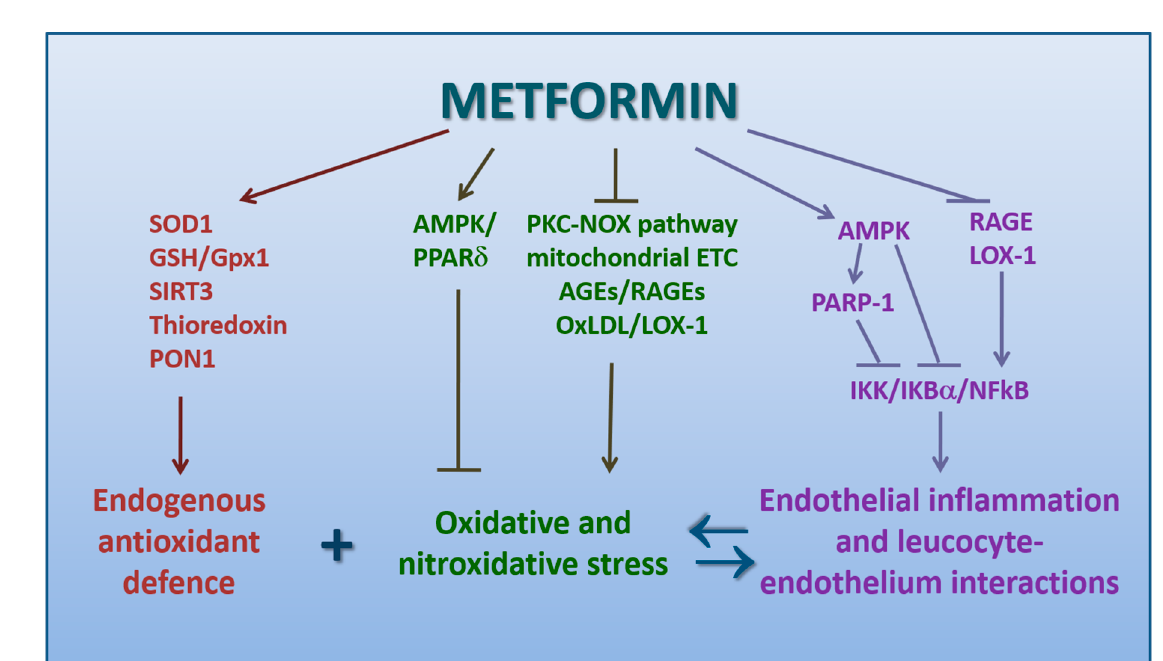
Figure 3. Schematic picture of the mechanisms by which metformin exerts a protective action against oxidative stress and endothelial dysfunction (direct arrows indicate the direction of the pathway, whilst blocked arrows stands for inhibition of that specific pathway. Double arrow stands instead for a bidirectional reaction).